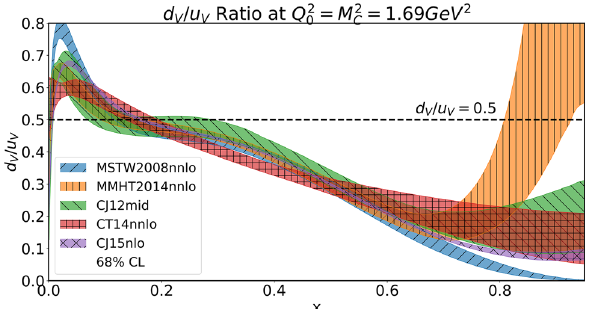
Fig. 6 The ratio of the d - to u -valence quark distributions for various PDF sets [36,38,41–43] calculated at the lowest point of Q 2 1 . 69 GeV 2 for which all the PDFs are